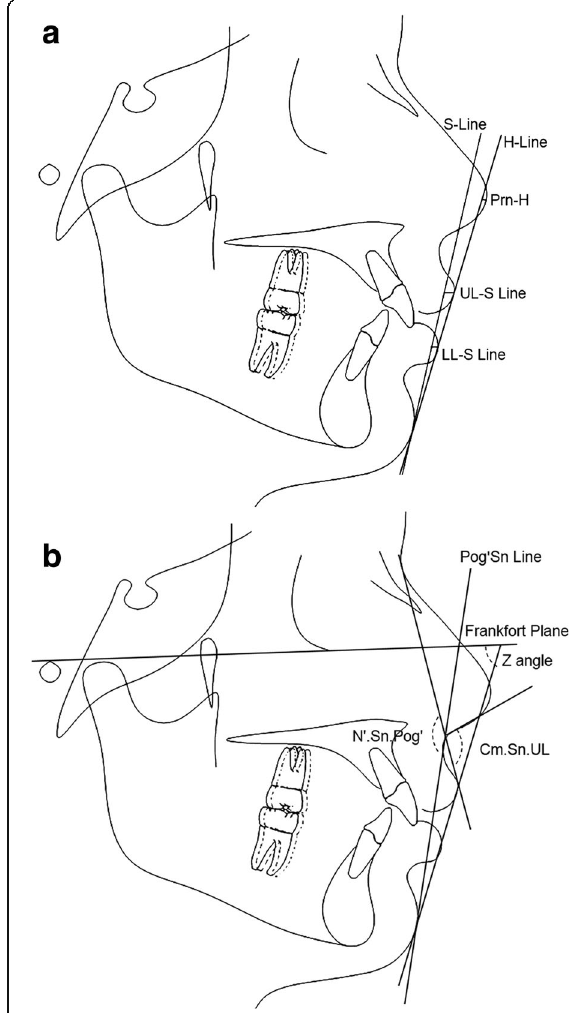
Fig. 4 Soft tissue variables. Linear measurements ( a ): UL-S Line; Prn-H; LL-S Line. Angular measurements ( b ): Z Angle; N ′ .Sn.Pog ’ ;